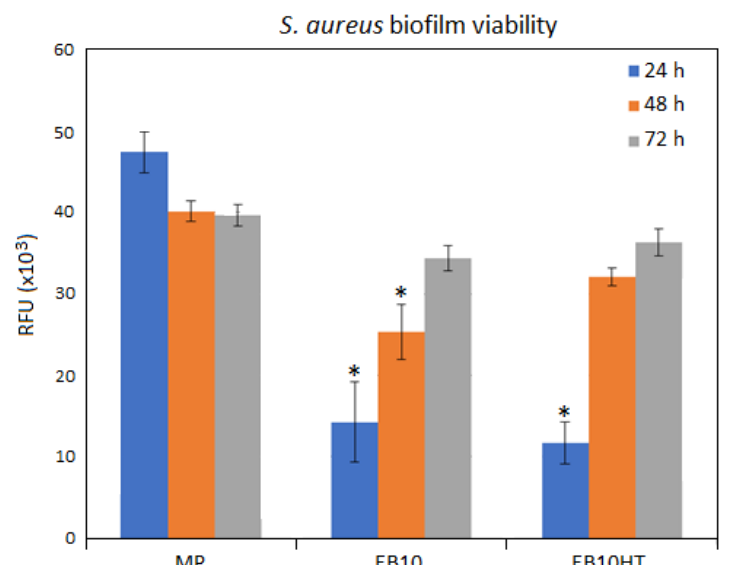
Figure 7. Bacterial adhesion evaluated in terms of metabolic activity. The grooved specimens (EB10